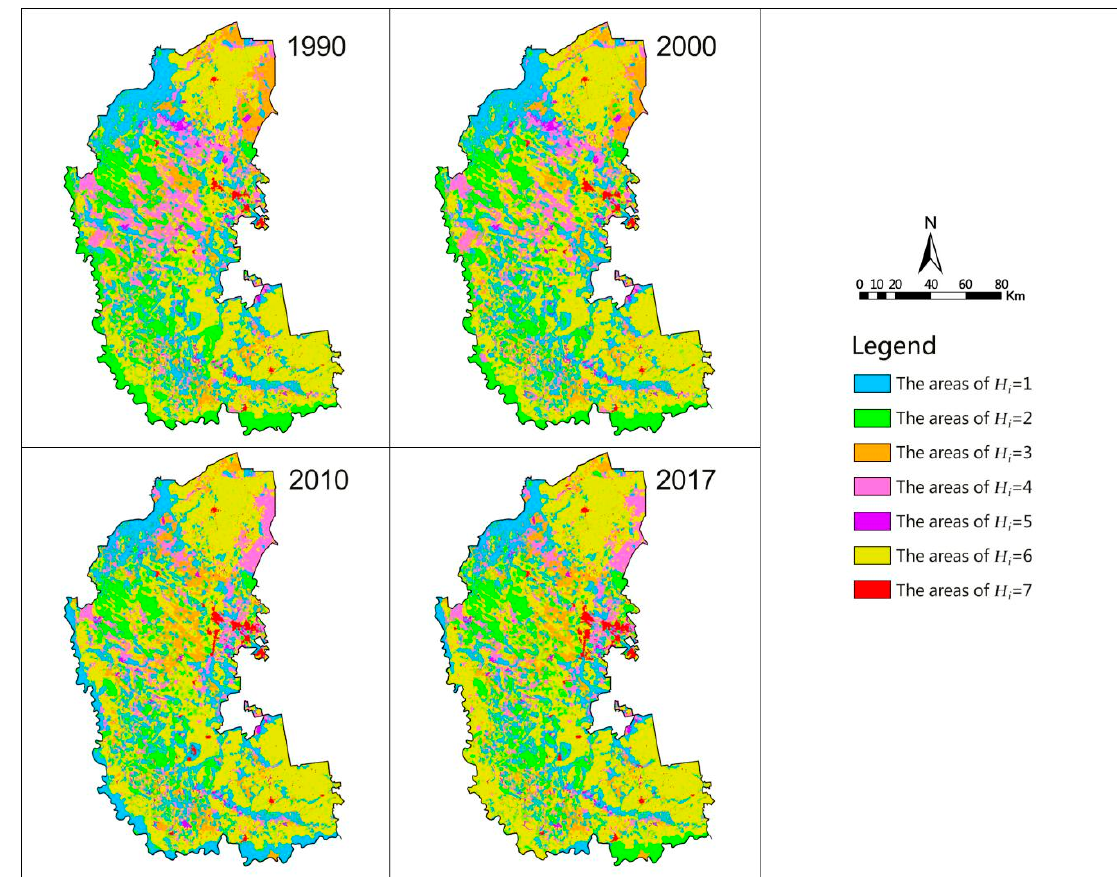
Figure 3. Reclassification land use of study area based on H i (the degree of hemeroby). Table 3. Land use conversion values of areas with different H i for the period 1990-2017 (km 2 ).